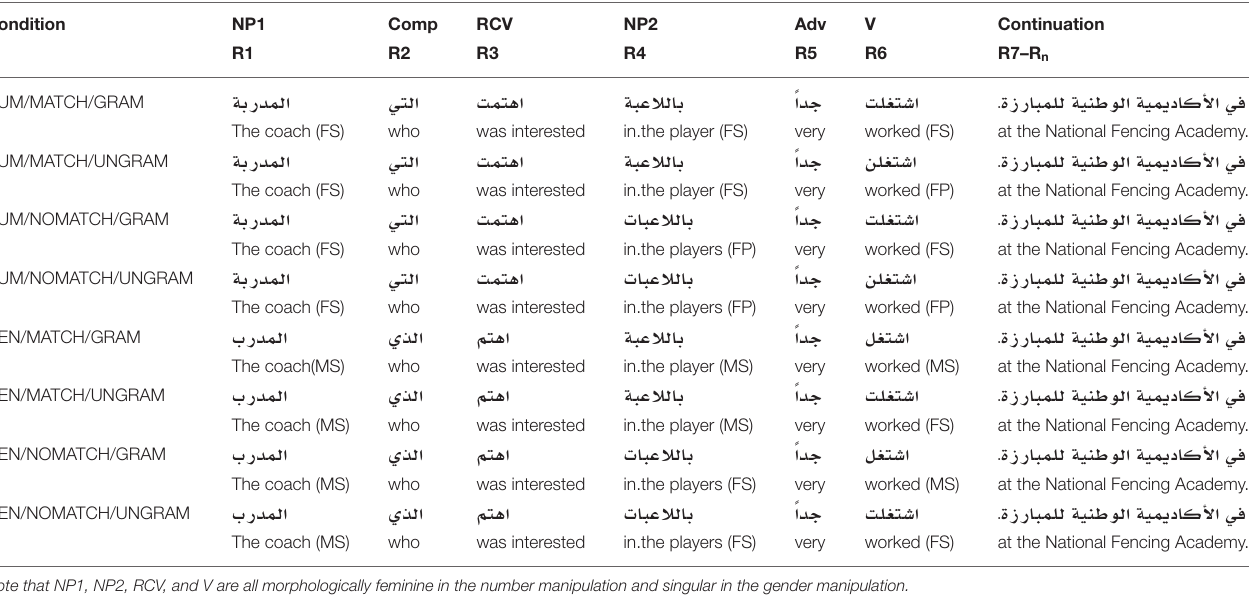
Table 8 | A complete item set for one stimulus in Experiment 5.